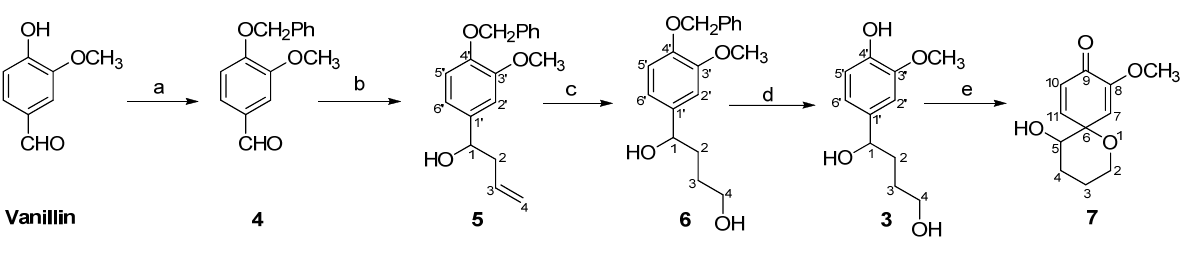
Scheme 1. Synthesis of spiroether 7